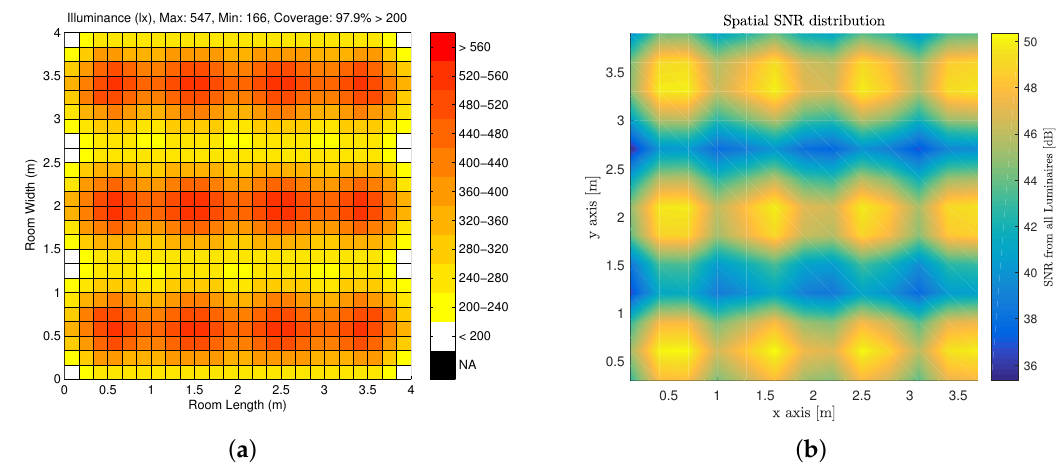
Figure 3. Model Description: ( a ) Illumination Pattern for Candidate Indoor Environment; and ( b ) Aggregate SNR Distribution over Candidate Indoor Environment for a R b = 20